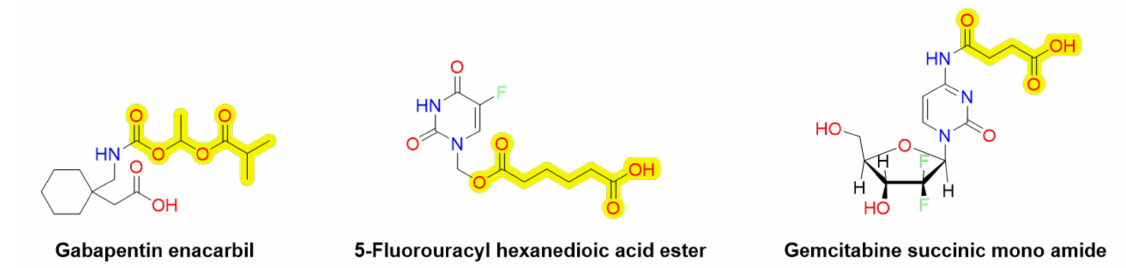
Figure 8. Molecular structures of prodrugs that can utilize MCT1 with promoieites highlighted with yellow